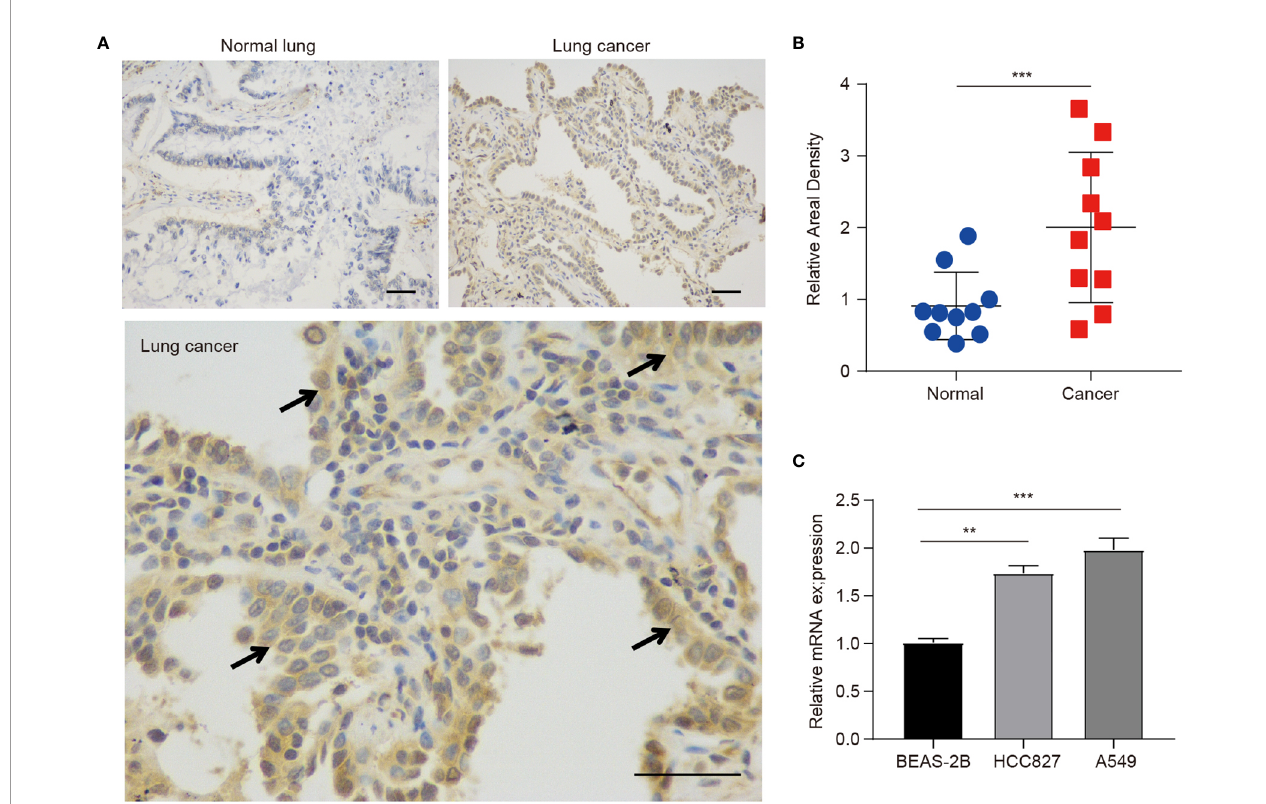
FIGURE 2 | Protein expression of hepcidin in lung cancer patients. (A) Immunohistochemical staining of hepcidin was performed in lung cancer and normal lung tissues. Representative images are shown. Scare bars, 50 m M. (B) The staining was quanti fi ed, as shown. The dot plot depicts the means and standard deviation of 10 images of lung cancer patient tissues and normal lung tissues. (C) Hepcidin expression in three different cell lines was examined by real-time PCR. The mean ± s.d. is shown. Statistical signi fi cance was determined using one-way ANOVA with the post hoc Tukey test. **p < 0.01, ***p <